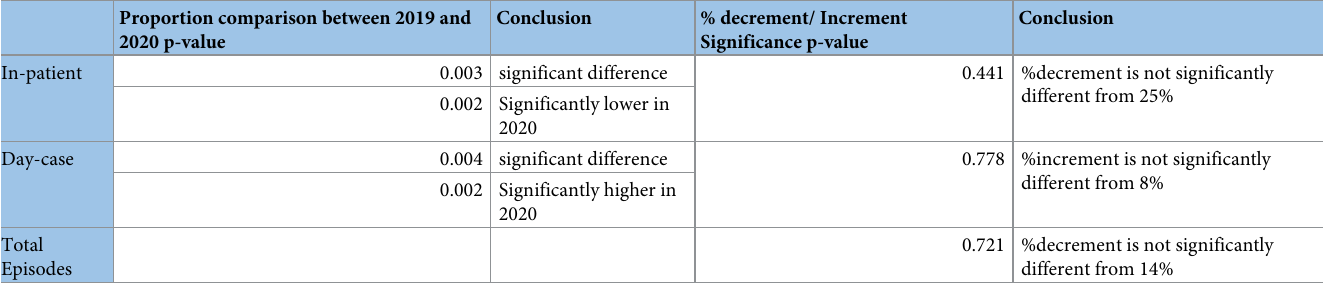
Table 3. Proportional comparison of in-patient, day- case based and total episodes in 2020 compared to 2019. Proportion comparison between 2019 and 2020 p-value